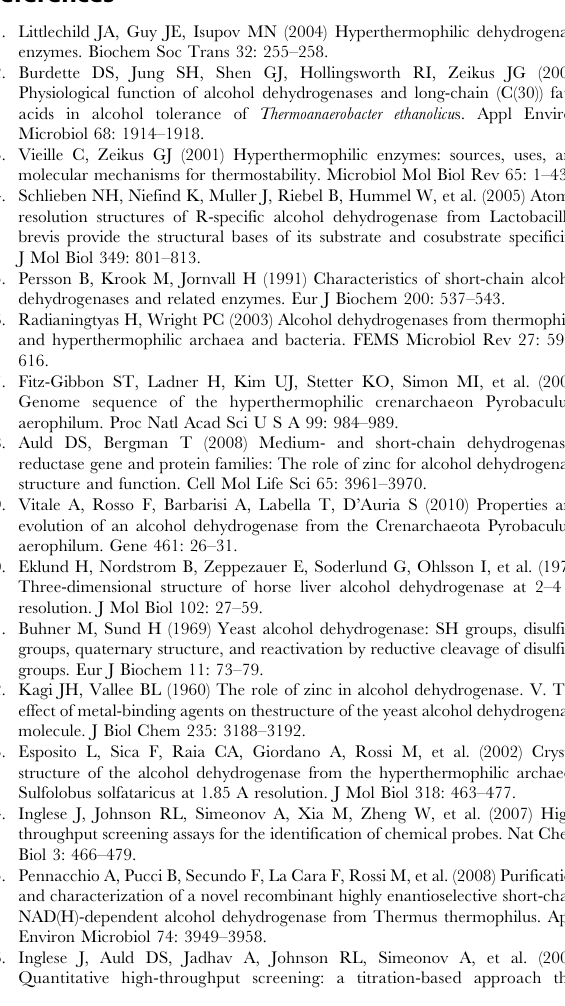
Figure S4 Comparison of the distribution of proline residues (red) in ADH-NADPH (green), HADH (blue, PDB: 5ADH), TBADH (gold, PDB: 1YKF) and YADH (coral, PDB: 2HCY). The structural Zn 2 + ions are represented